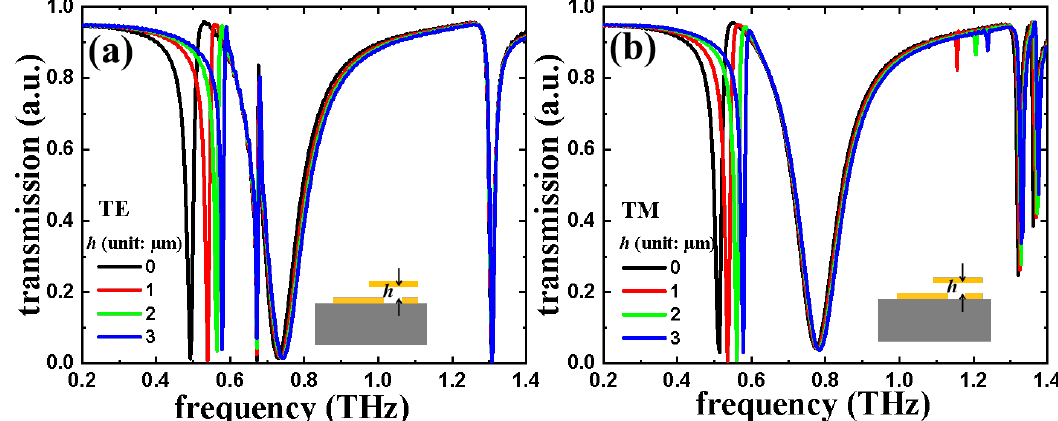
Figure 8. Electromagnetic responses of TTM by changing the h parameter in ( a ) TE and ( b ) TM modes.